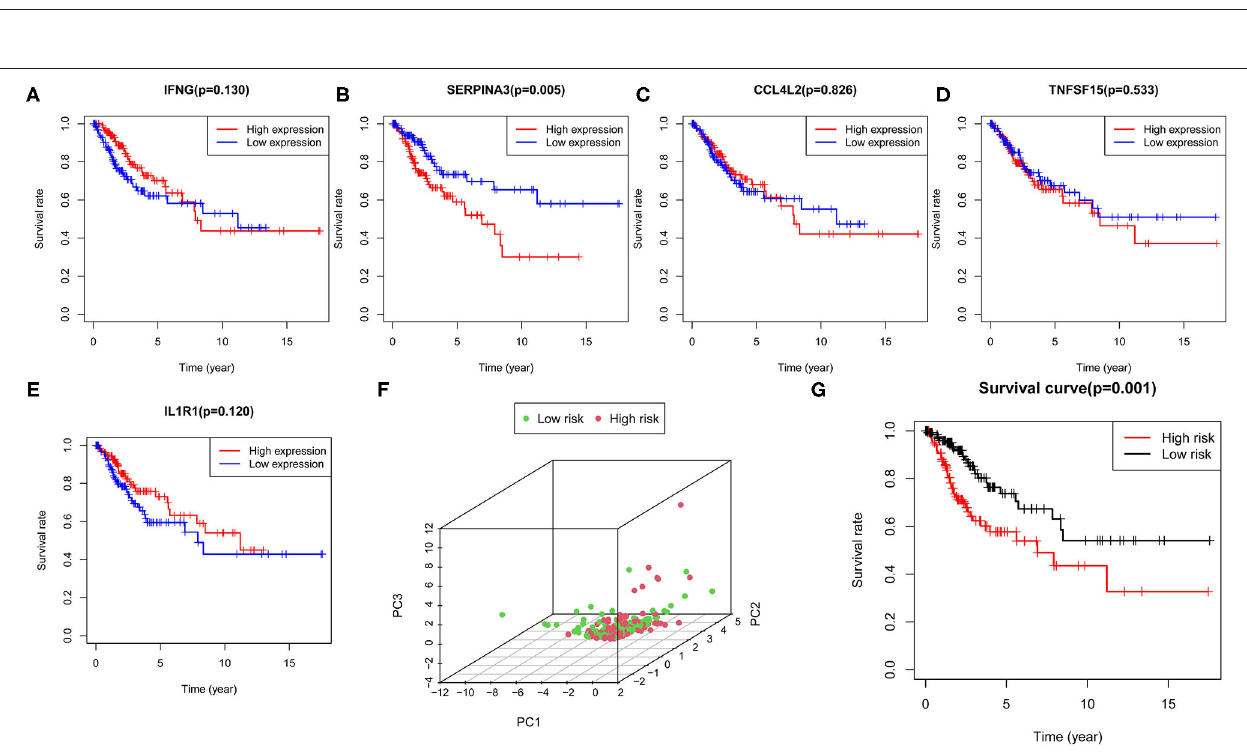
FIGURE 6 | Construction of the prognostic model. (A–E) Correlation of the expression levels of five hub genes with survival outcomes. (F) PCA plot represents the distinction between the high- and low-risk groups. (G) Survival curve indicating significant differences in survival outcomes between the high- and low-risk groups.